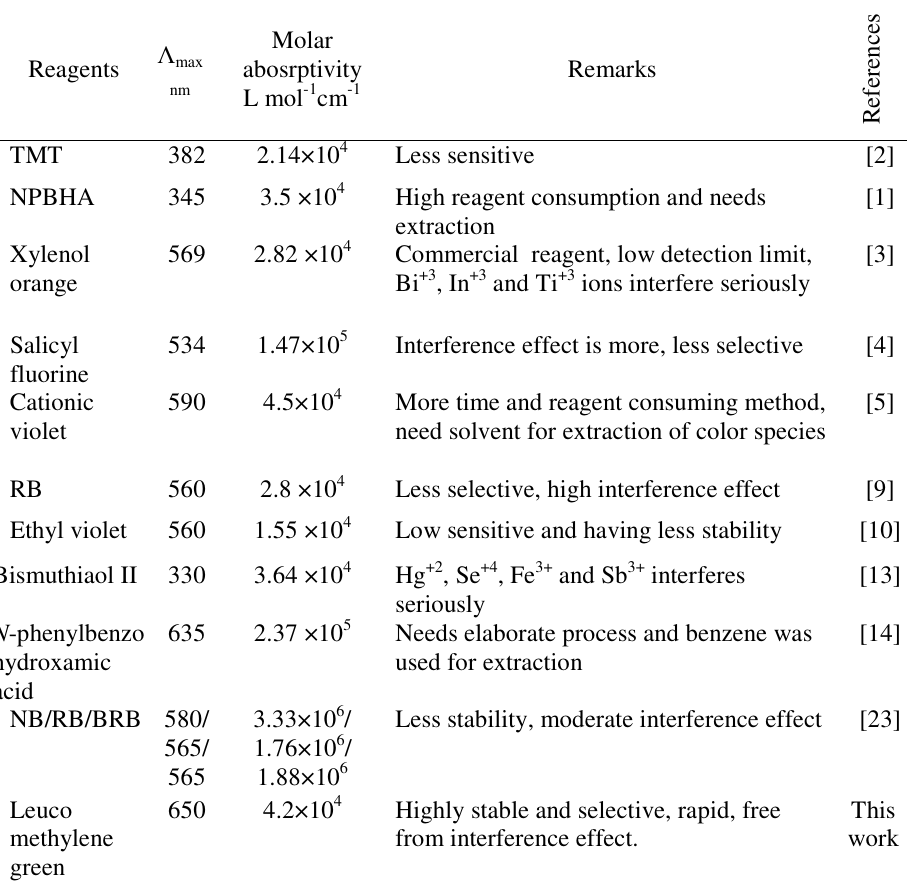
Table 4. Comparison of proposed methods with reported methods for spectrophotometer determination of tellurium(IV) in various